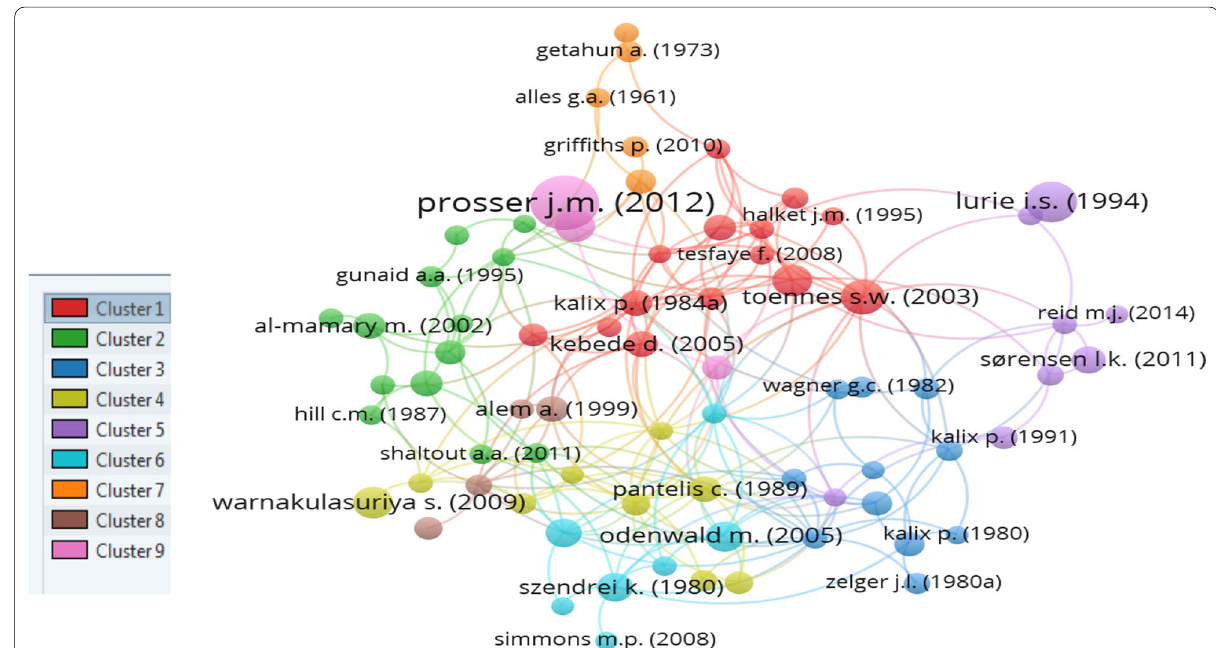
Fig. 6 Visualization of documents with a minimum number of 50 citations. The map was built using VOSviewer software. Nice clusters were the results from these 113